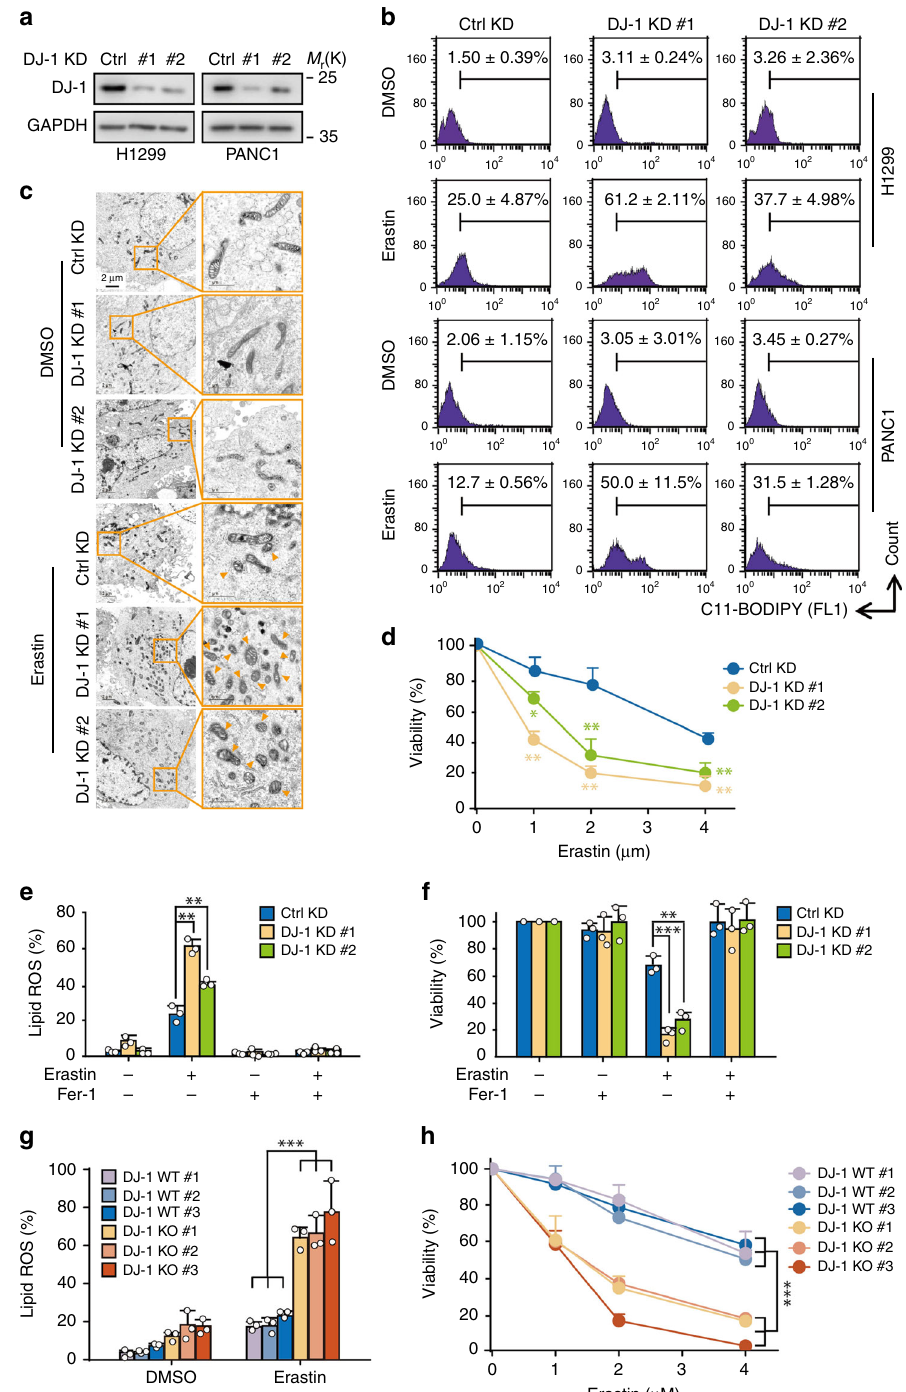
Fig. 1 DJ-1 KD enhances ferroptotic cell death. a Western blot analysis of DJ-1 expression in indicated DJ-1 KD H1299 and PANC1 cells. Independent experiments are repeated three times and representative data are shown. b Indicated KD H1299 and PANC1 cells were treated with erastin (2 μ M) for 12 h, and lipid ROS production was assayed by fl ow cytometry using C11-BODIPY. Representative data are shown and the statistical analysis is from three independent experiments. c Representative transmission electron microscopy images of control KD or DJ-1 KD H1299 cells treated with erastin (2 μ M, 12 h). A minimum of ten cells per treatment condition were examined. Orange triangle representative ’ s shrunken mitochondria. Independent experiments are repeated three times and representative data are shown. d Indicated DJ-1 KD H1299 cells were treated with erastin (1 – 4 μ M) for 36 h, and cell viability was assayed. e Indicated DJ-1 KD H1299 cells were treated with erastin (2 μ M) with or without ferrostatin-1 (Fer-1, 1 μ M) for 12 h, and lipid ROS production was assayed. f Cell viability was assayed in indicated DJ-1 KD H1299 cells treated for 36 h with erastin (2 μ M) with or without Fer-1 (1 μ M). g DJ-1 WT and KO H1299 cells were treated with erastin (2 μ M) for 12 h, and lipid ROS production was assayed. h Cell viability was assayed in indicated DJ-1 WT and KO H1299 cells treated for 36 h with erastin (1 – 4 μ M). Data shown represent mean ± SD from three independent experiments. Comparisons were made using the two-tailed, unpaired Student ’ s t -test; * p < 0.05, ** p < 0.01, *** p <